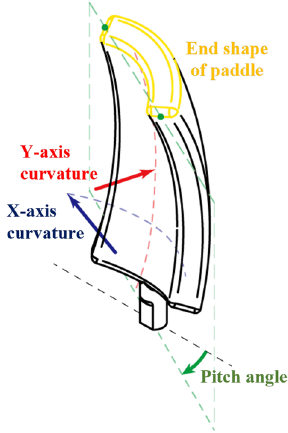
Figure 4. Design parameters of ASPW.